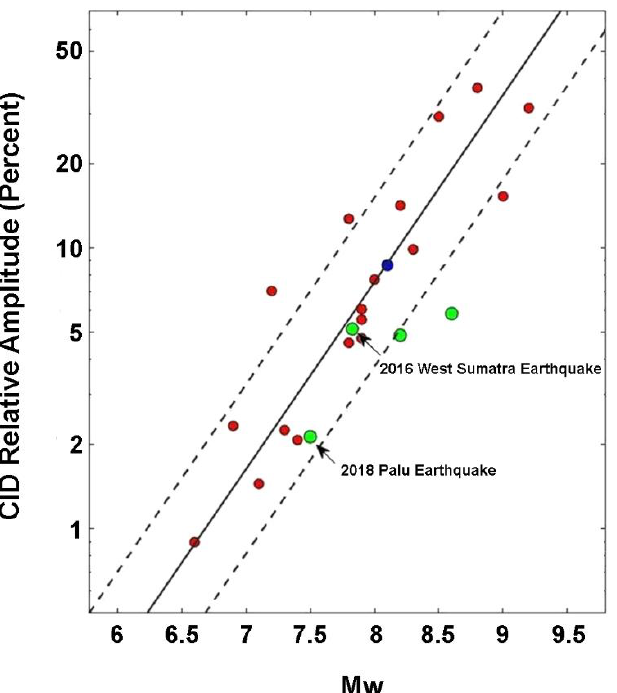
Figure 6. Comparison of the moment magnitude of 21 earthquakes taken from Cahyadi and Heki [16] and 2 earthquakes from this research; the amplitude of CID STEC is normalized by the background of the vertical TEC. The fault mechanism is illustrated by the symbol colors: thrust fault (red), normal fault (blue), and green (strike-slip).